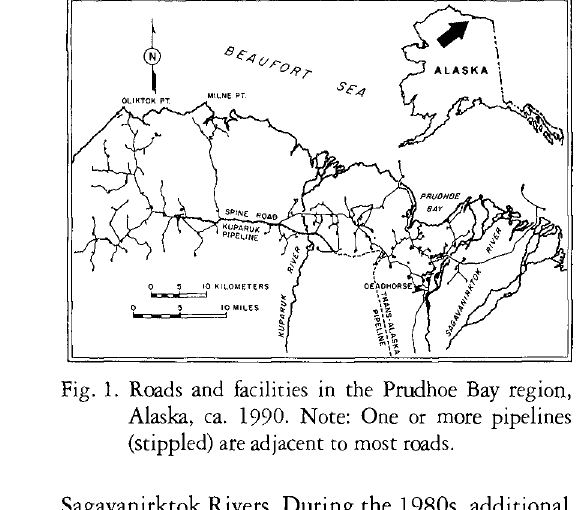
Fig. 1. Roads and facilities in the Prudhoe Bay region, Alaska, ca. 1990. Note: One or more pipelines (stippled) are adjacent to most roads.